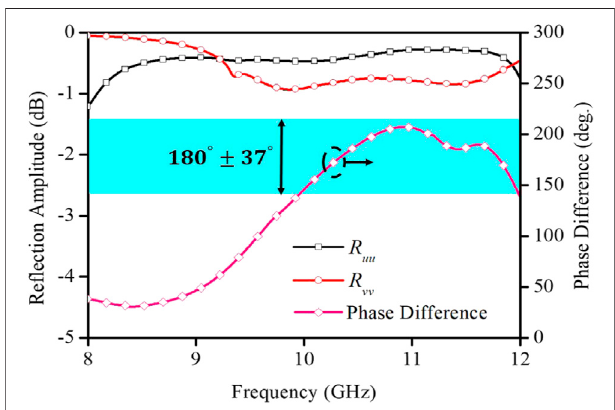
FIGURE 6 | Simulation results of the re fl ection amplitudes and phase difference along the u and v directions.